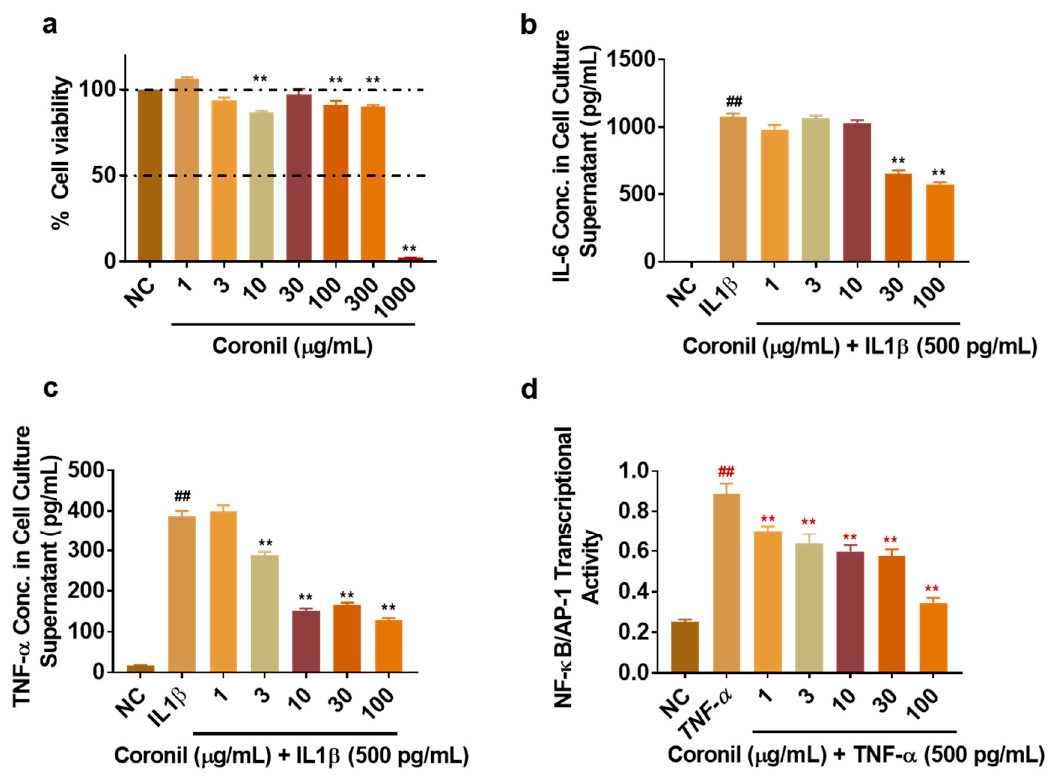
Figure 9. Coronil decreases the pro-inflammatory responses in vitro. A549 cells were treated with various concentrations of CN for 24 h and measured for toxicological profile. ( a ) Cytotoxicity of CN on A549 cells expressed as % cell viability. Cells were pre-treated with CN followed by co-treatment with CN + IL-1 β for 24 h and assayed for the secretion of cytokines using Enzyme Linked Immunosorbent Assay (ELISA). Secretion of ( b ) IL-6 and ( c ) TNF- α . ( d ) HEK Blue TNF- α reporter Secreted Alkaline phosphatase (SEAP) assay for NF- κ B / AP-1 transcriptional activity. HEK blue cells stably expressing the with TNF- α and measuring SEAP activity after 24 h. Data are presented as the means ± SEM ( n = 2 in triplicates). **, ## , p < 0.001 by one-way ANOVA; ## represents significance compared to NC